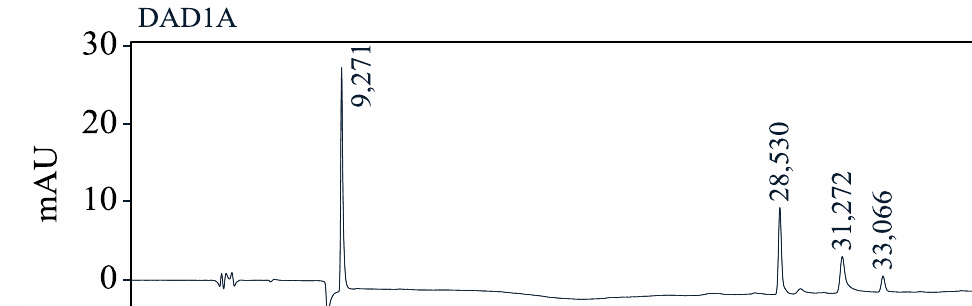
Fig. 4. RP HPLC chromatogram of aminocaproic acid official reference standard of the State Pharmacopoeia of Ukraine after derivatization. I is dansyl chloride (9,3 min); II is aminocaproic acid derivative (28,5 min).